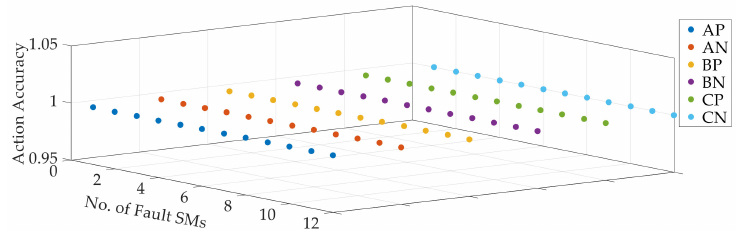
Figure 16. The influence of number of faulted SMs on the action accuracy.